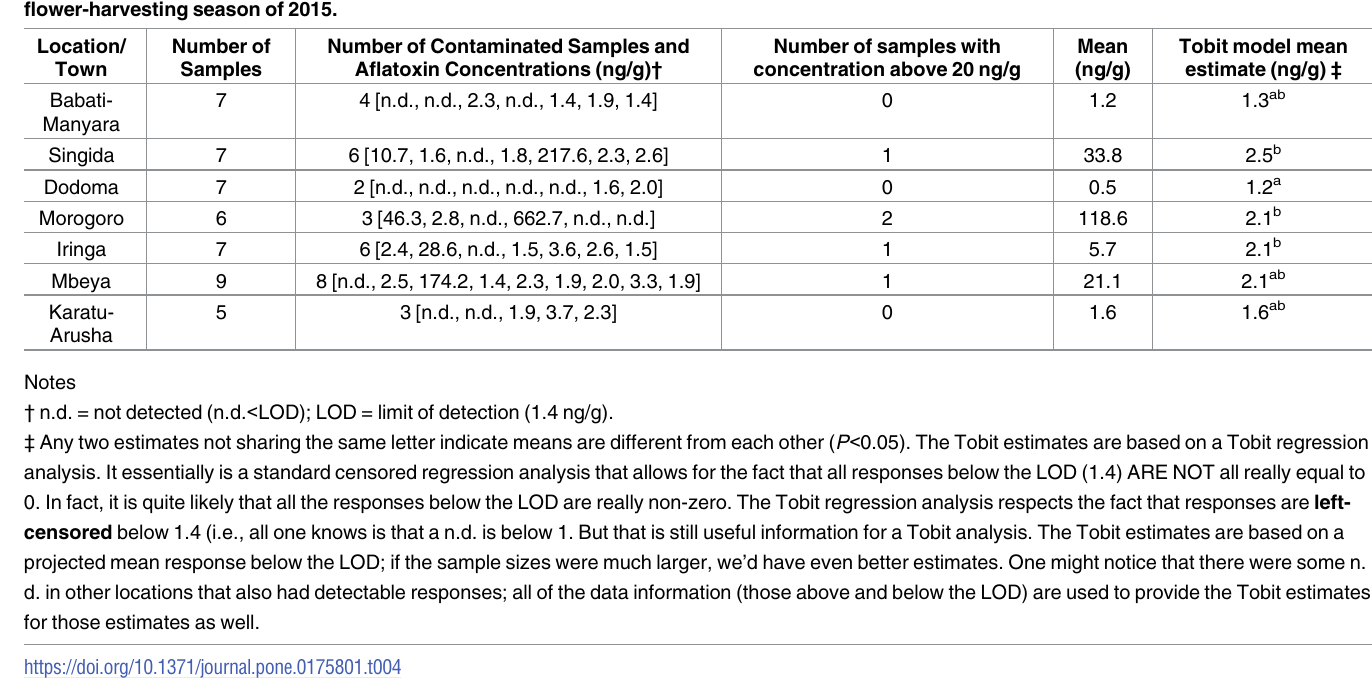
from the seed samples reported in Table 4. Morogoro and Dodoma samples had higher aver- age aflatoxin concentrations of 149.0 and 120.6 ng/g, respectively as compared to Singida (11.3